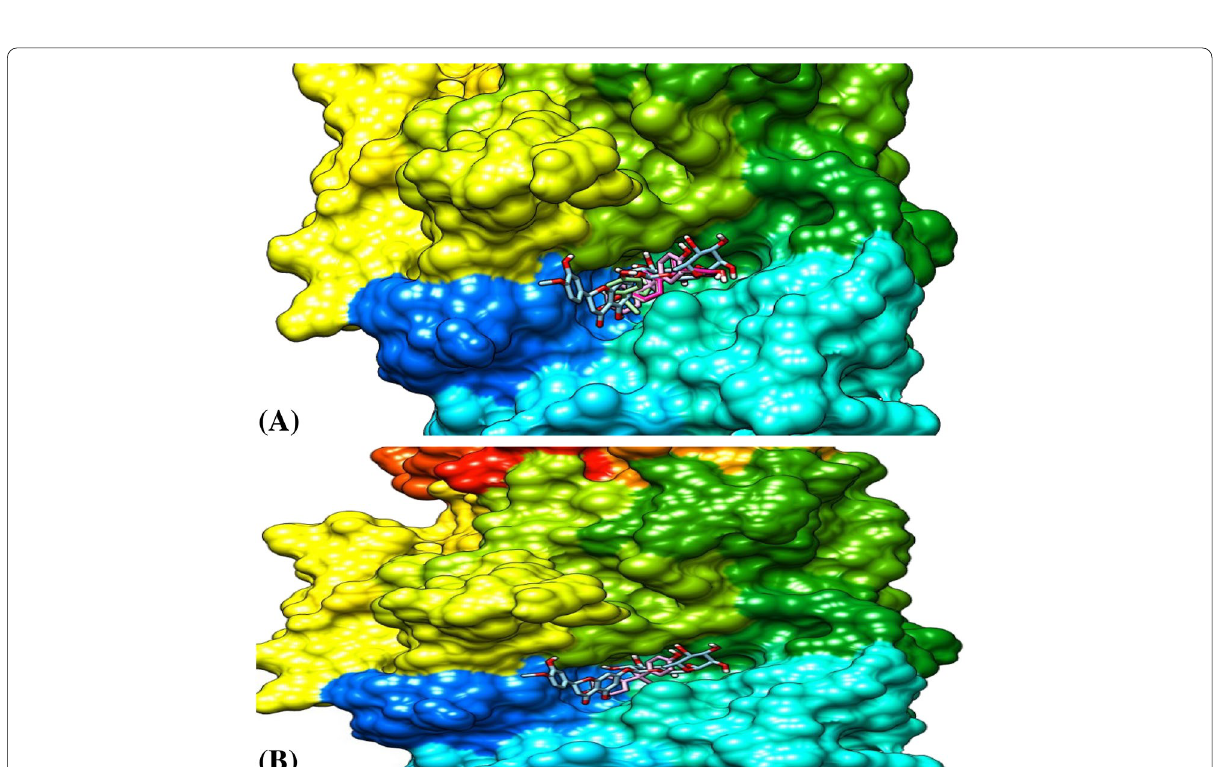
Fig. 6 The binding pose of the ligands at the same binding site of α-glucosidase. (A) . The best model of hesperidin and 6 models of bisphenol A. (B) . The binding pose of the best conformation of the ligands and the